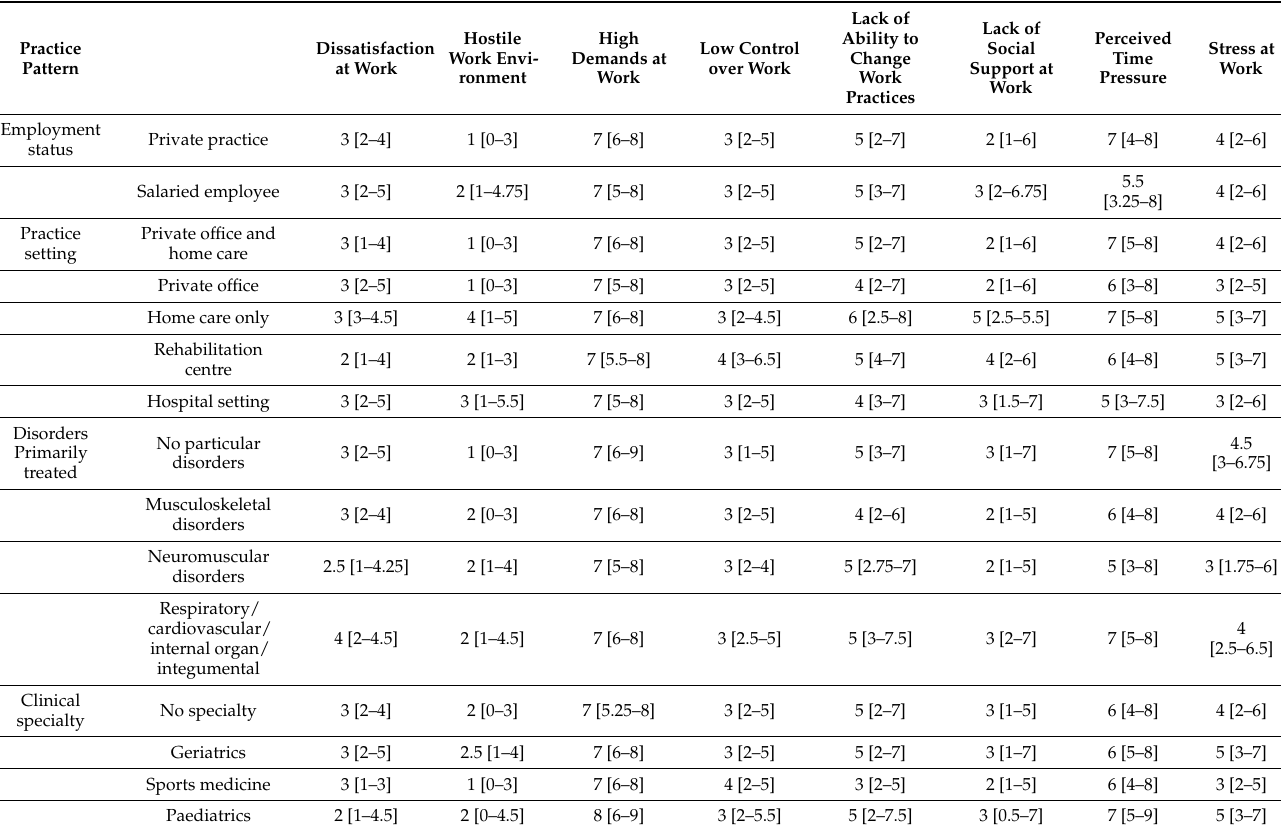
Table A2. Physiotherapists’ Perceived Levels (Median [IQR]) of Exposure to Psychosocial and Organisational Risk Factors, as a Function of Practice